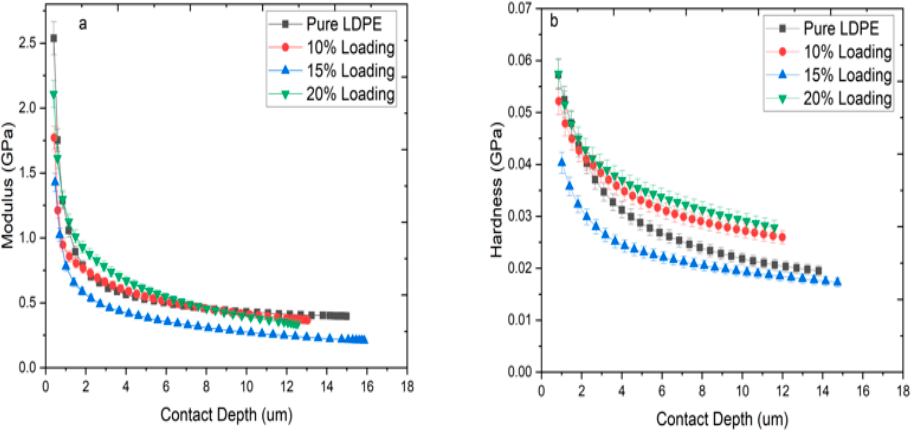
Figure 4. ( a ) Indentation modulus and (b ) hardness as a function of contact depth for pure LDPE and ChCl pretreated RHW biocomposites with different RHW loadings (10, 15, and 20 wt.%) at 100 mN.